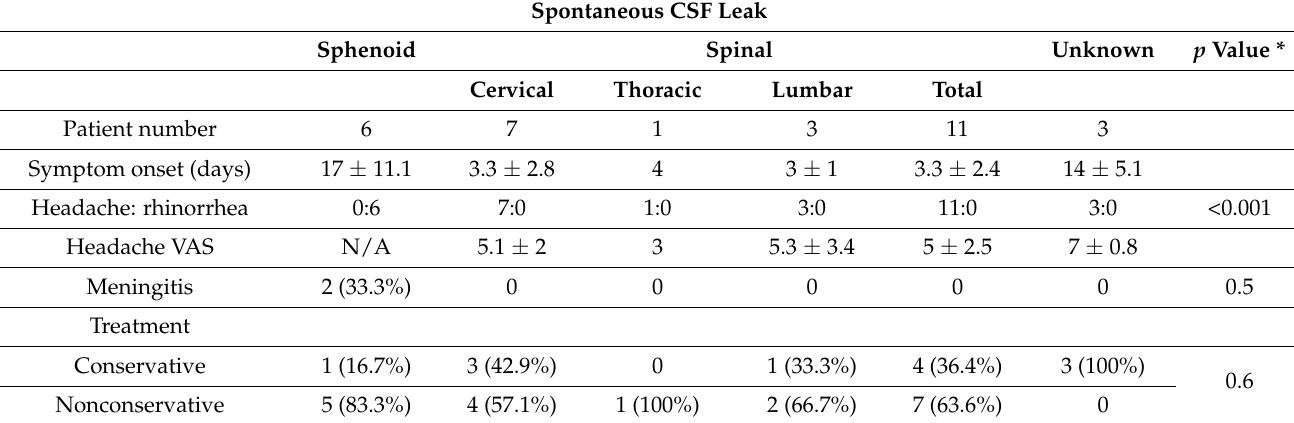
Table 3. Subgroup analysis of spontaneous CSF